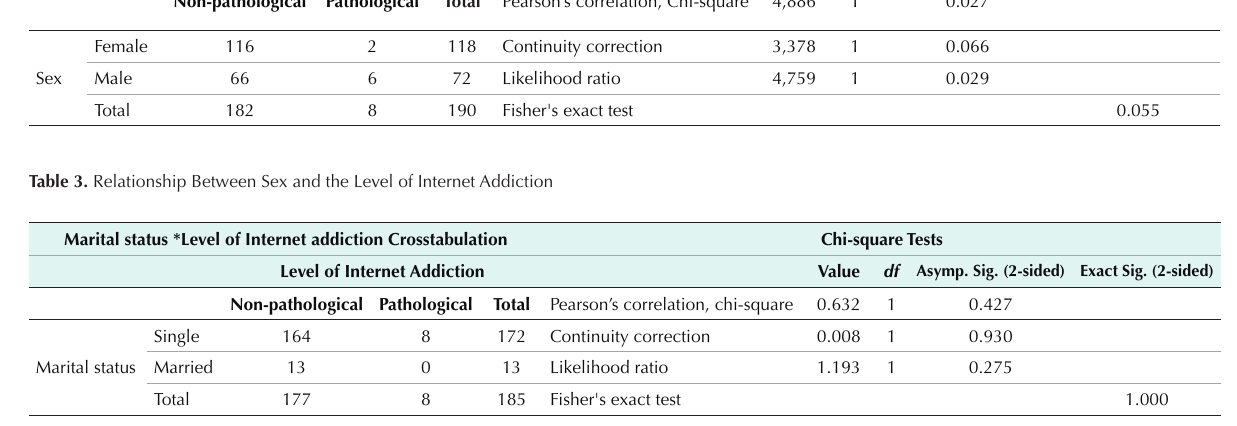
Table 2. Relationship Between Sex and the Level of Internet Addiction Sex * Level of Internet Addiction Crosstabulation Chi-square Tests Level of Internet addiction Non-pathological Pathological Total Pearson’s correlation, Chi-square 4,886